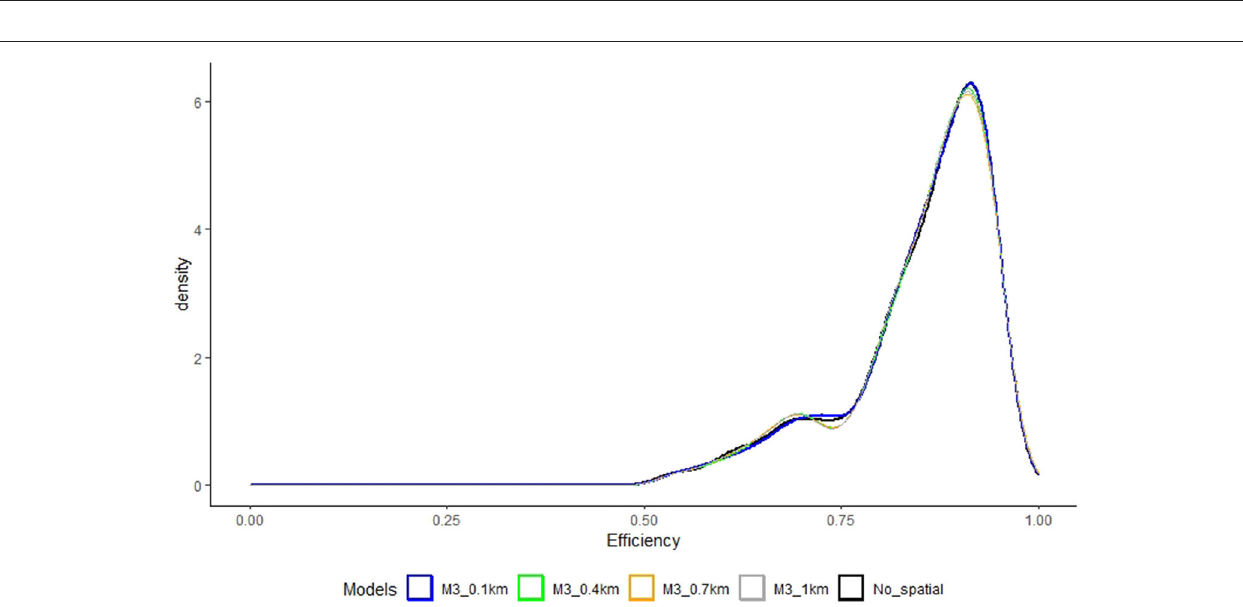
FIGURE 6 | Model 2 vs. non spatial: Farm technical efficiency distribution for irrigated farms at different cut-off distances.